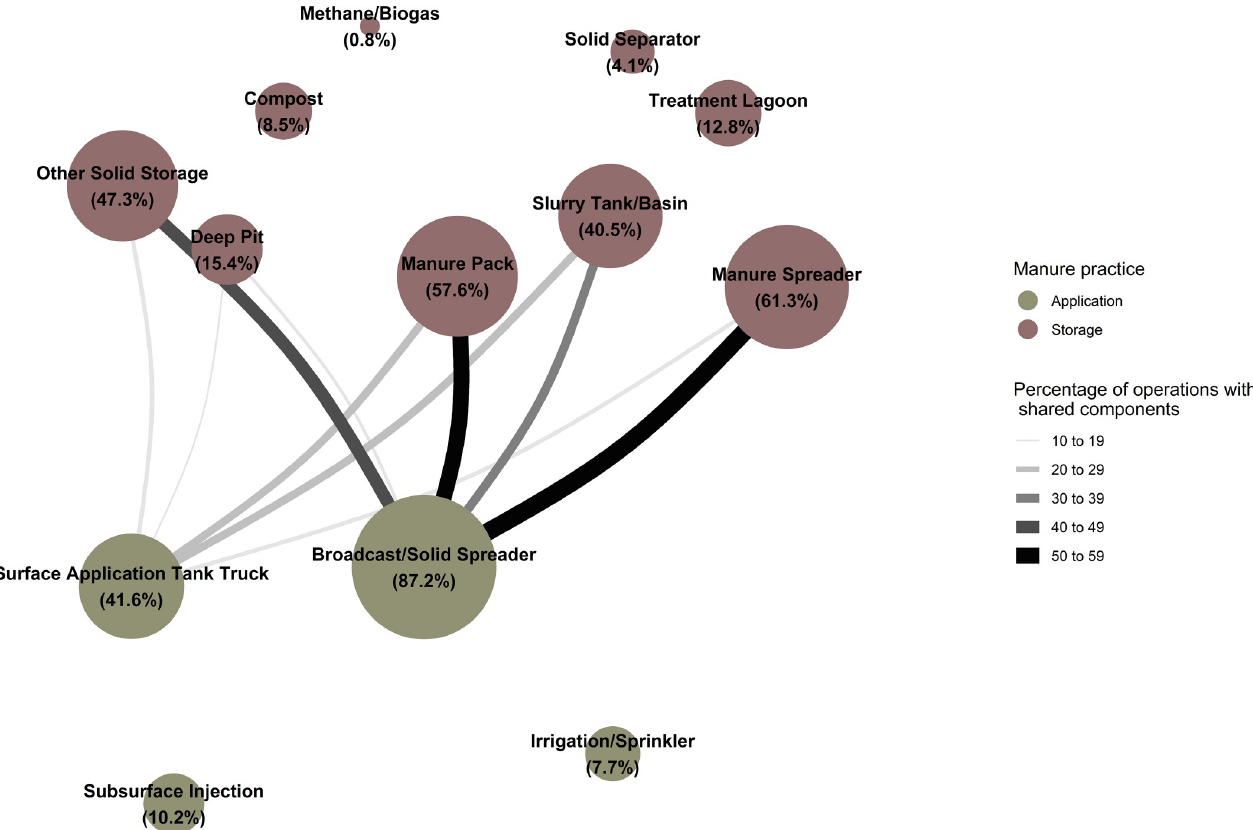
Fig 5. Network graph showing the percentage of operations practicing the given manure storage (red) and application (green) strategies (diameter of nodes) and the percentage of operations practicing storage-application pairs of strategies together (width of edges, with widths colored by group based on magnitude of percentage). Edges representing percentages of 10 or less were suppressed Edge percentages for this figure are located in Supporting Information S2